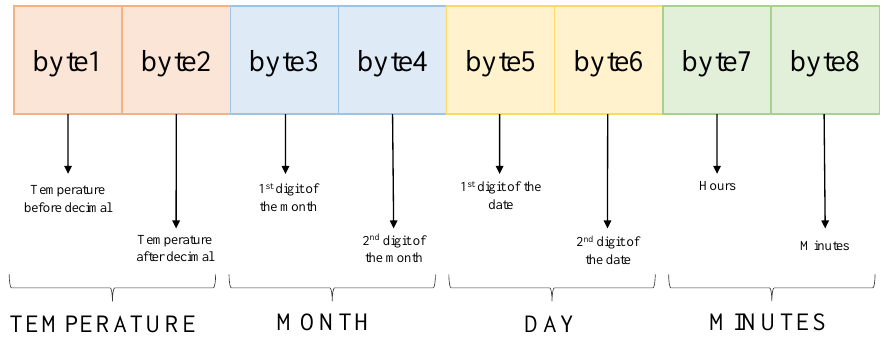
Figure 11. Data preparation